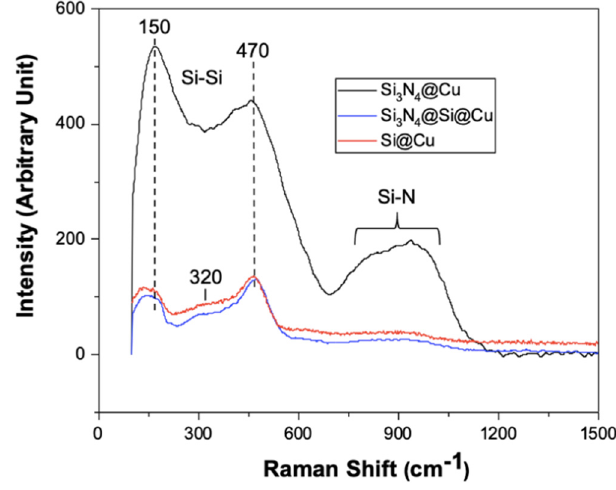
Figure 2. Raman spectra of Si-based anode materials deposited on a Cu sheet via RF magnetron sputtering.